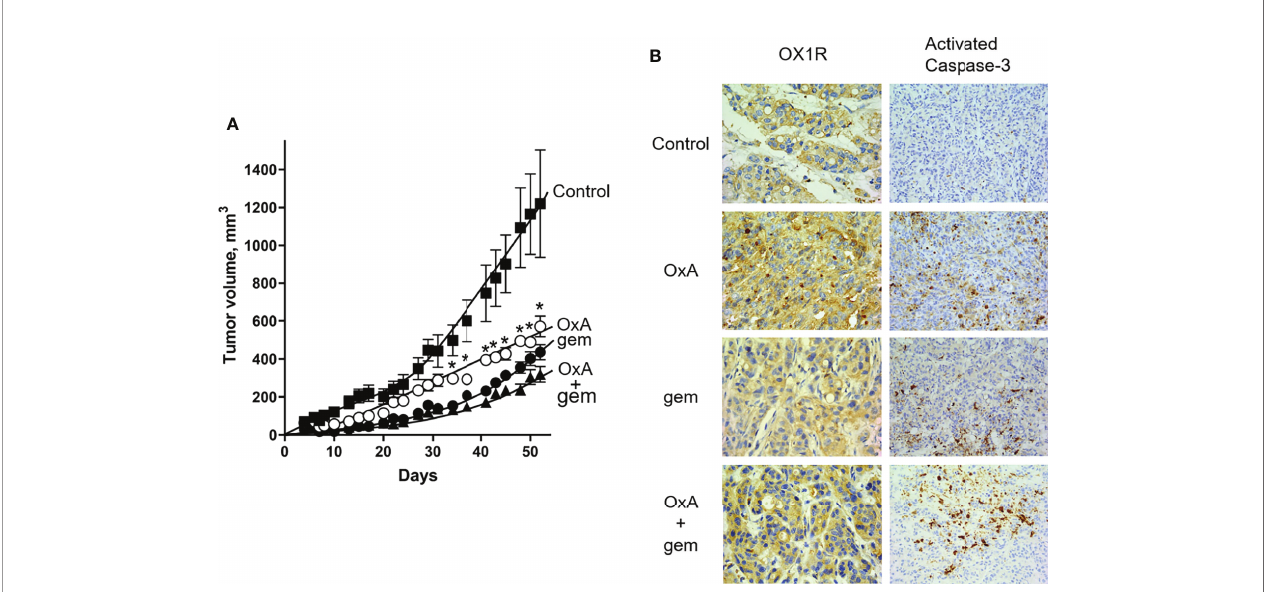
FIGURE 3 | Preclinical study and histological analysis of anti-tumoral effect of OxA and gemcitabine. (A) Impact of three injections/week of 100 µg OxA, 120 µg gemcitabine, or 100 µg OxA plus 120 µg gemcitabine on volume of tumors developed from subcutaneously xenografted ASPC-1 cells in nude mice. The tumor development was measured with a caliper. (B) Determination of OX1R expression and caspase-3 activation by histological immunostaining in xenografted AsPC-1 resected tumors from mice treated with PBS (control), OxA (OxA), gemcitabine (gem), or OxA plus gemcitabine (OxA + gem). Magni fi cation was 40× (OX1R expression) and 20× (caspase-3 activation). Data were the means ± SEM of six tumors in each group. *p<0.05.